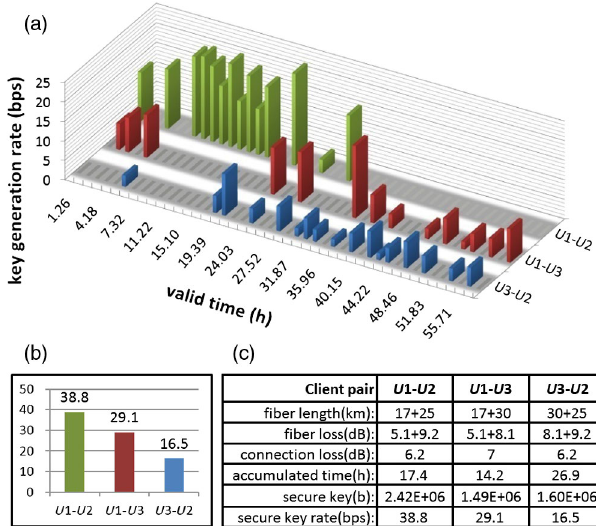
FIG. 4. (a) The secure key rate array of each run with a valid time of 1.0 – 1.3 hours for user pair ( U 1 − U 2 ), 0.8 – 1.2 hours for ( U 1 − U 3 ), and 1.2 – 2.1 hours for ( U 3 − U 2 ). (b) The overall key rate (unit: bps) with accumulated data of each user pair in 17.4 hours ( U 1 − U 2 ), 14.2 hours ( U 1 − U 3 ), and 26.9 hours ( U 3 − U 2 ). (c) The system parameters, including the loss, the accumulation time, and secure key rate, are